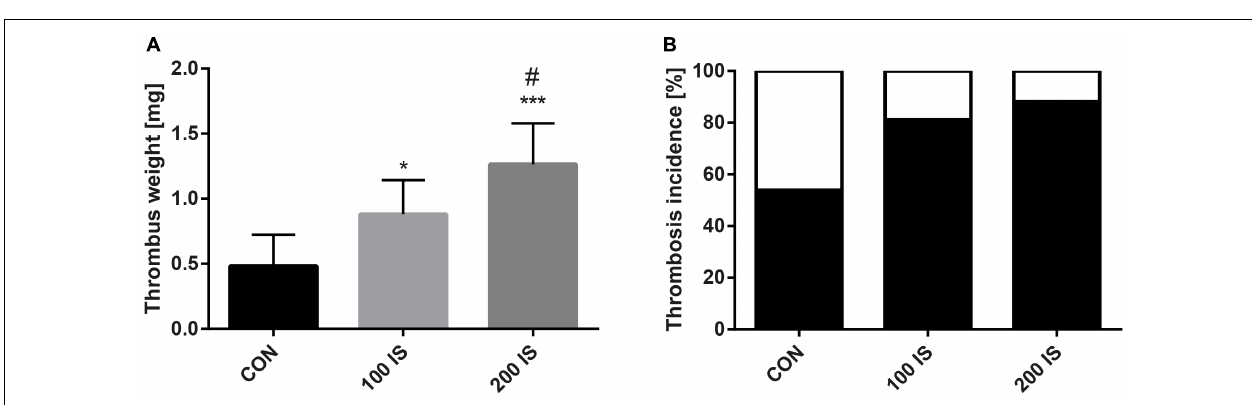
FIGURE 2 | (A) The weight of developed thrombus in arterial thrombosis model. (B) The frequency of incidence of thrombosis. Data from (A) are shown as the mean ± SD. CON, control group; 100 IS, group receiving IS in the dose of 100 mg/kg b.w./day; 200 IS, group receiving IS in the dose of 200 mg/kg b.w./day; IS, indoxyl sulfate; ∗ p < 0.05 compared to control; ∗∗∗ p < 0.001 compared to control; # p < 0.05 compared to 100 IS